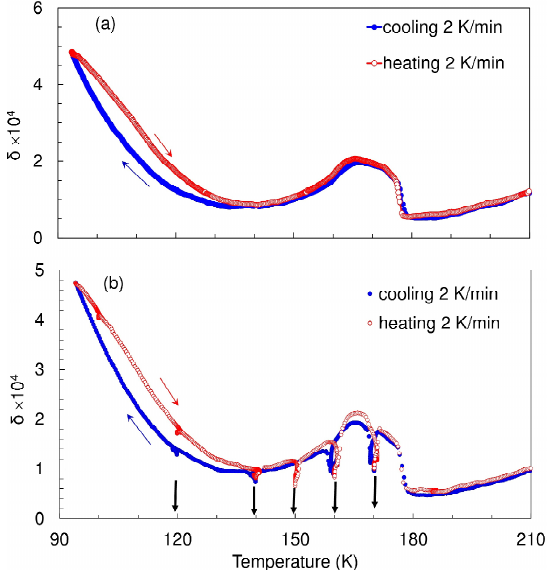
Fig. 1 . Internal friction,  , on cooling to 95K and subsequent heating at 2K/min: (a) continuous scan; (b) measurements with interruptions on cooling and heating at 100, 120, 140, 150, 160, 170, and 185K (temperatures are marked by vertical arrows) for 40 min of isothermal dwelling. Oscillatory strain ampli- tude  = 10 -5 0